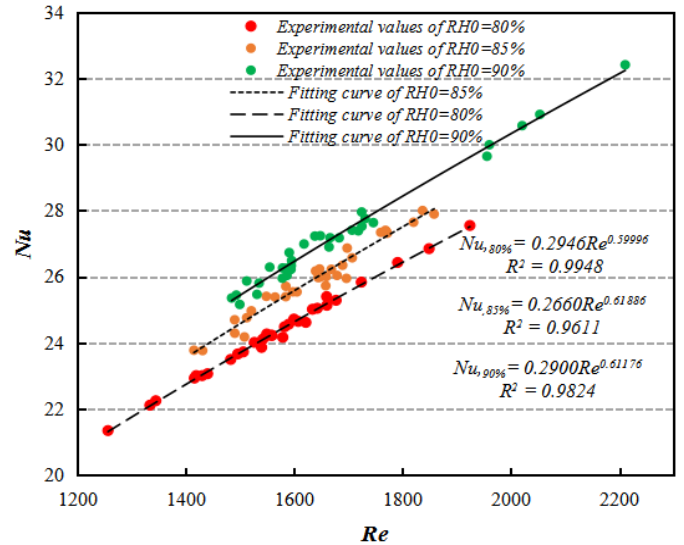
Figure 9. The relationship between the Nu and Re for different RH 0 values.